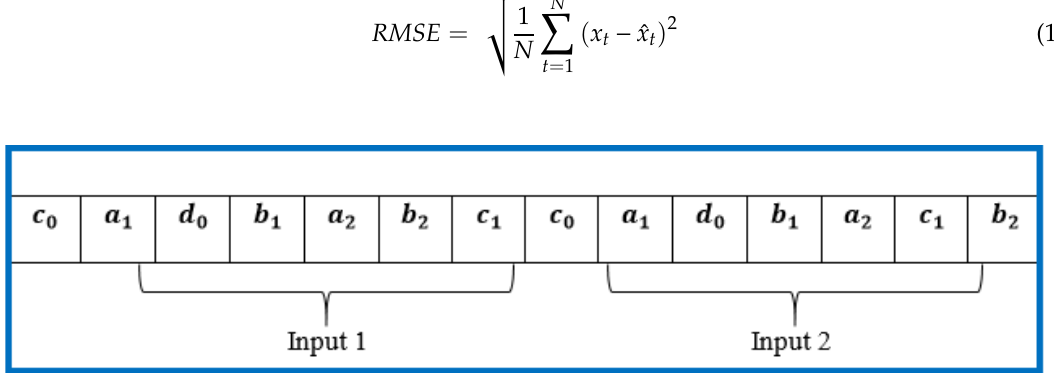
Figure 10. Vector for the fuzzy logic controller.